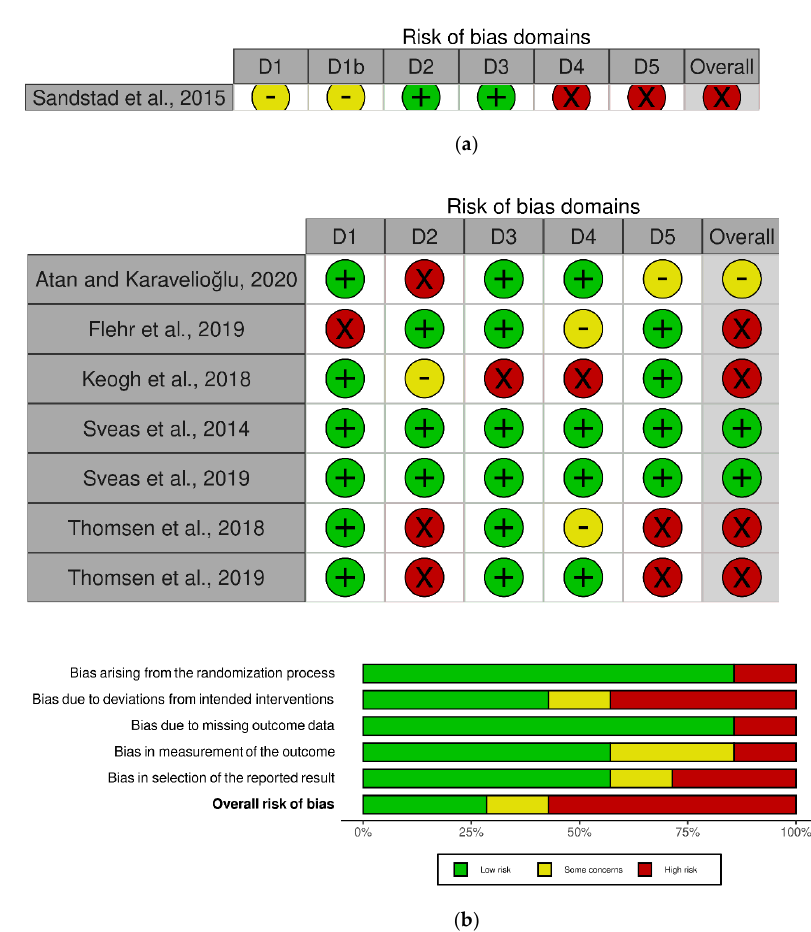
Figure A2. Risk of bias summary. Review authors’ judgements about each risk of bias item for each included study (risk of bias 2 tool) and risk of bias graph. Review authors’ judgements about each risk of bias item presented as percentages across all included studies (risk of bias 2 tool). ( a ) D1: randomization process, D2: deviations from the intended interventions, D3: missing outcome data, D4: measurement of the outcome D5: selection of the reported result; ( b ) D1: randomization process, D2: deviations from the intended interventions, D3: missing outcome data, D4: measurement of the outcome, D5: selection of the reported